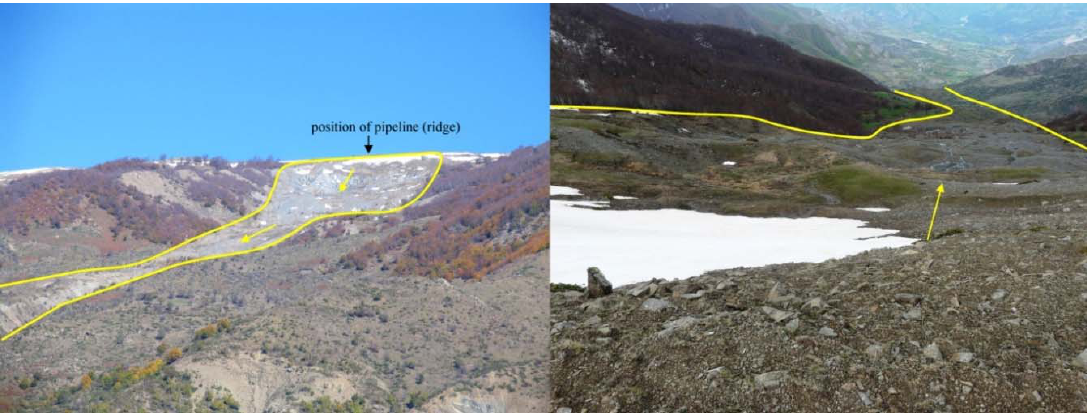
Figure 11. A view of landslide ALS ‐ 20A. Upslope view of the crest and landslide mass ( left ) and downslope view ( right ) taken from the pipeline RoW. The yellow lines show the landslide (earthflow according to the classification of [22]) boundaries, the yellow arrows the direction of movement and the black arrow indicates the position of the pipeline axis.